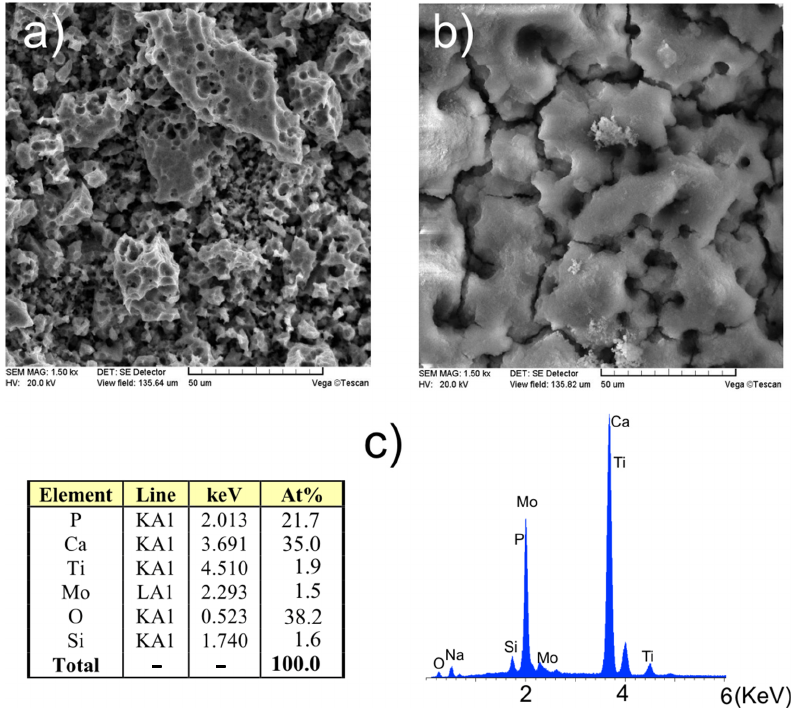
Figure 4. SEM micrographs of Ti23Mo 3BG after anodic oxidation ( a ) and additional Ca-P deposition ( b ) with EDS spectrum ( c